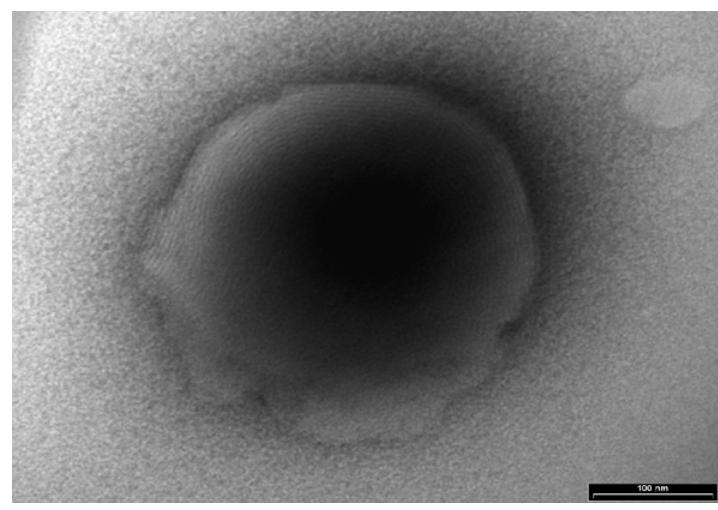
Figure 3. TE micrographs of buspirone NDS after three months of storage at room temperature (RT). Table 1. Stability parameters for buspirone nasal nanovesicular delivery system (NDS) at zero time and after three months of storage at RT (mean ± SD).